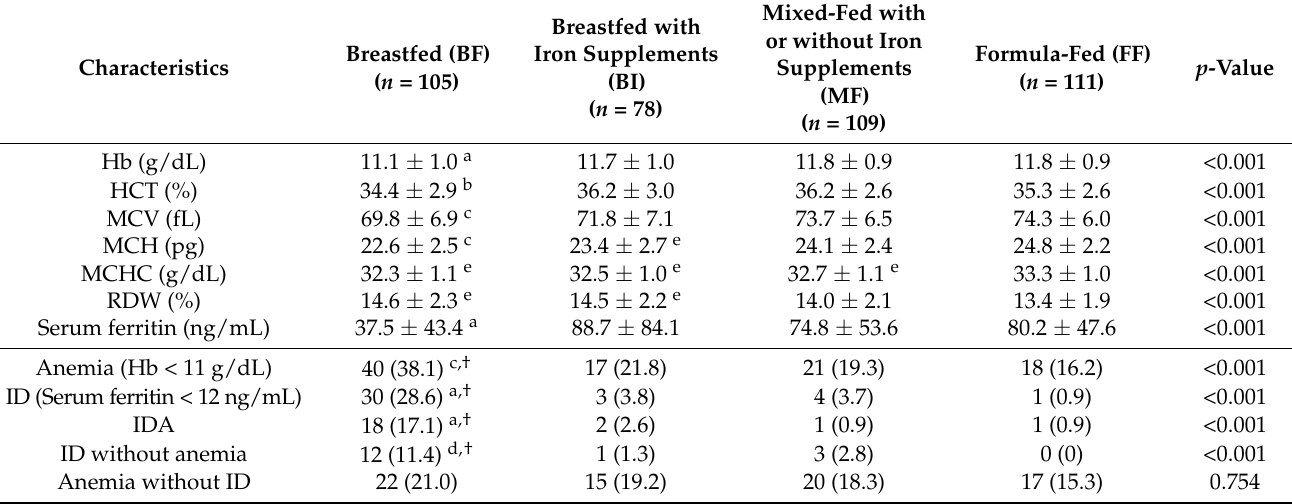
Table 2. Laboratory characteristics of infants categorized by feeding practices.